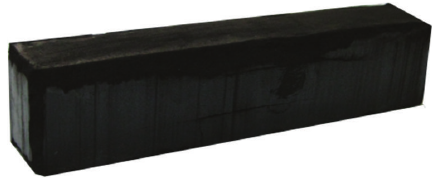
Figure 4: Physical map of the coal